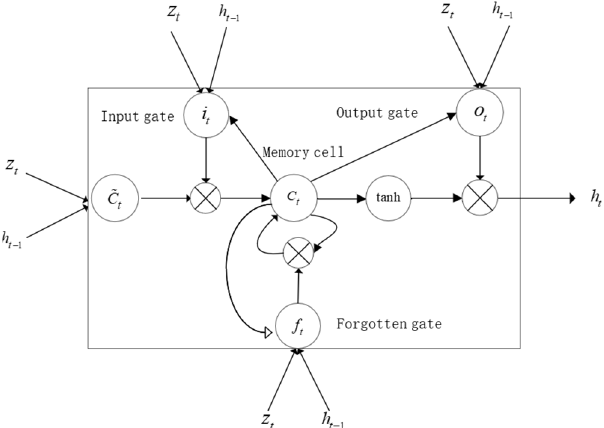
Figure 3. LSTM structure diagram.